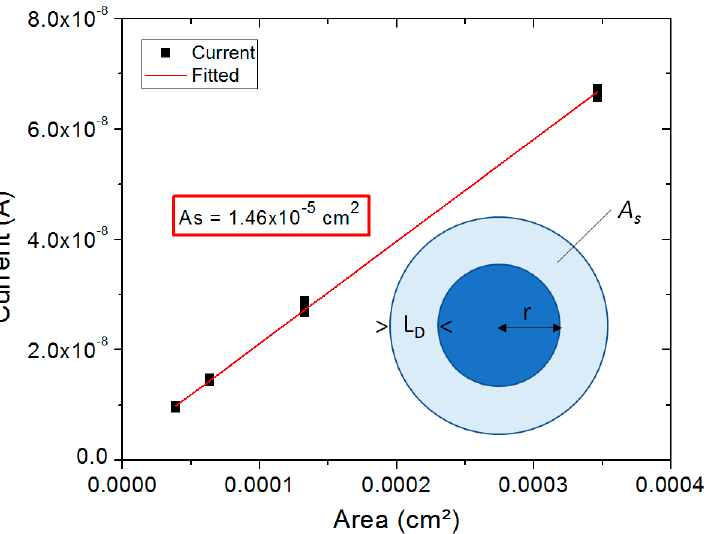
Figure 6. Dark current’s dependence on the shallow-etched mesa area at T = 150 K. Inset shows the view of the circular mesa diode with the additional surface area A s around it due to additional lateral diffusion length L D .